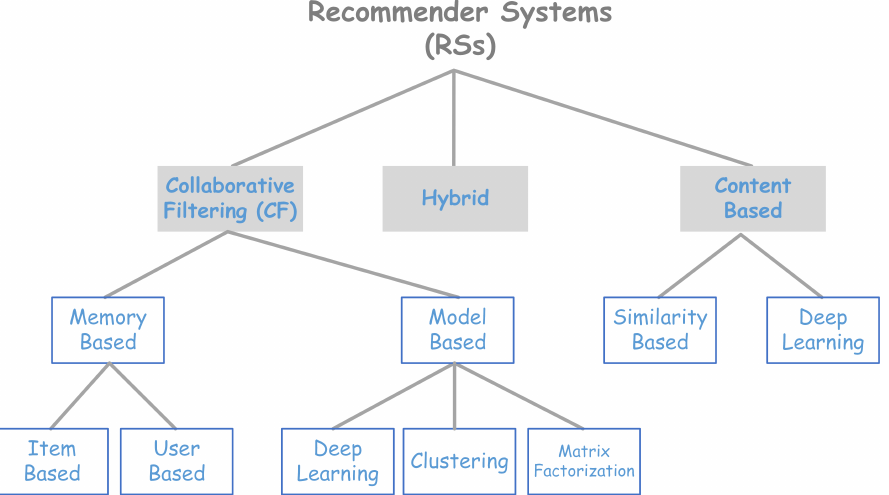
Figure 2. Methods for creating recommender